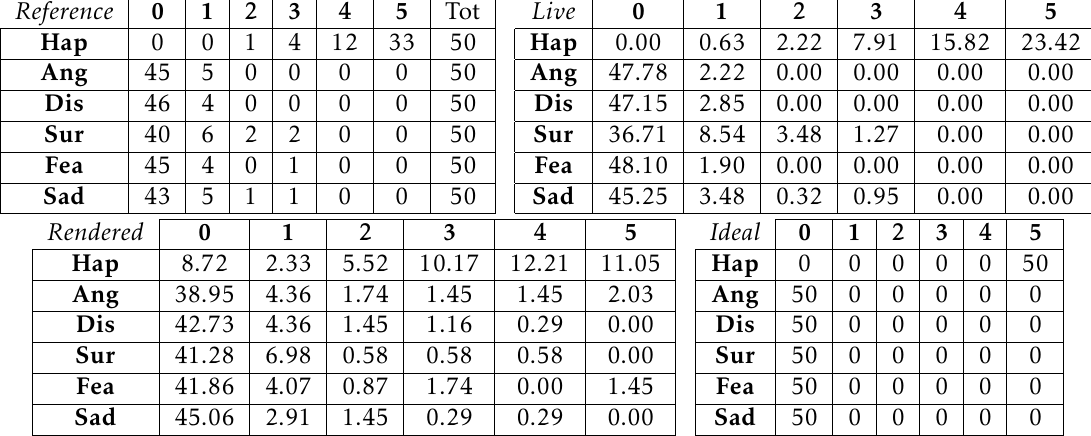
Table 2. The rates distribution for the happiness expression: i) the rates obtained by the reference videos, ii) the rates for the live videos, iii) the rates for the rendered videos, and iv) the ideal distribution. The live and rendered rates have been scaled to match the same total per line of the reference rates. The ideal table is generated ad-hoc.